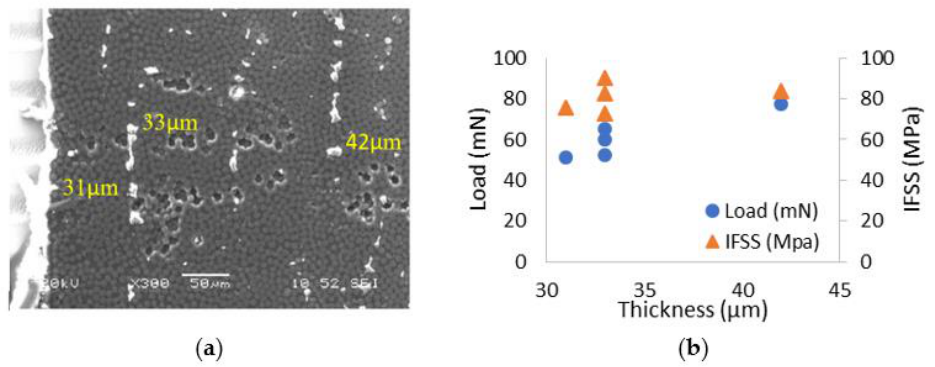
Figure 10. Sample U10F1: ( a ) the area for push-out test with different thicknesses ( b ) the critical load and the relevant IFSS with different thicknesses.